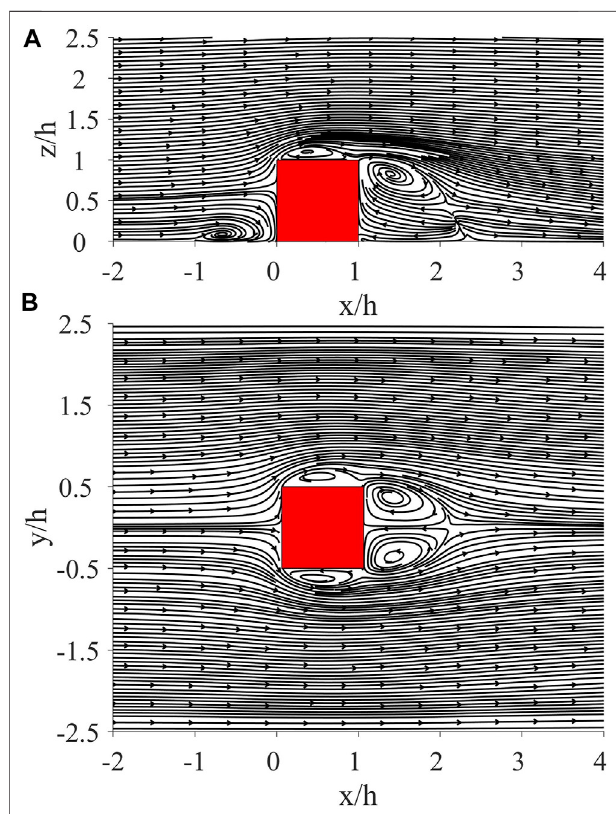
FIGURE 3 | Mean velocity streamlines at (A) slice y (cid:3) 0; and (B) slice z (cid:3) 0 . 5 h of the fl ow over 8 × 8 × 8cm cube at Re h (cid:3) 2 × 10 4 in the fl ow model validation study.